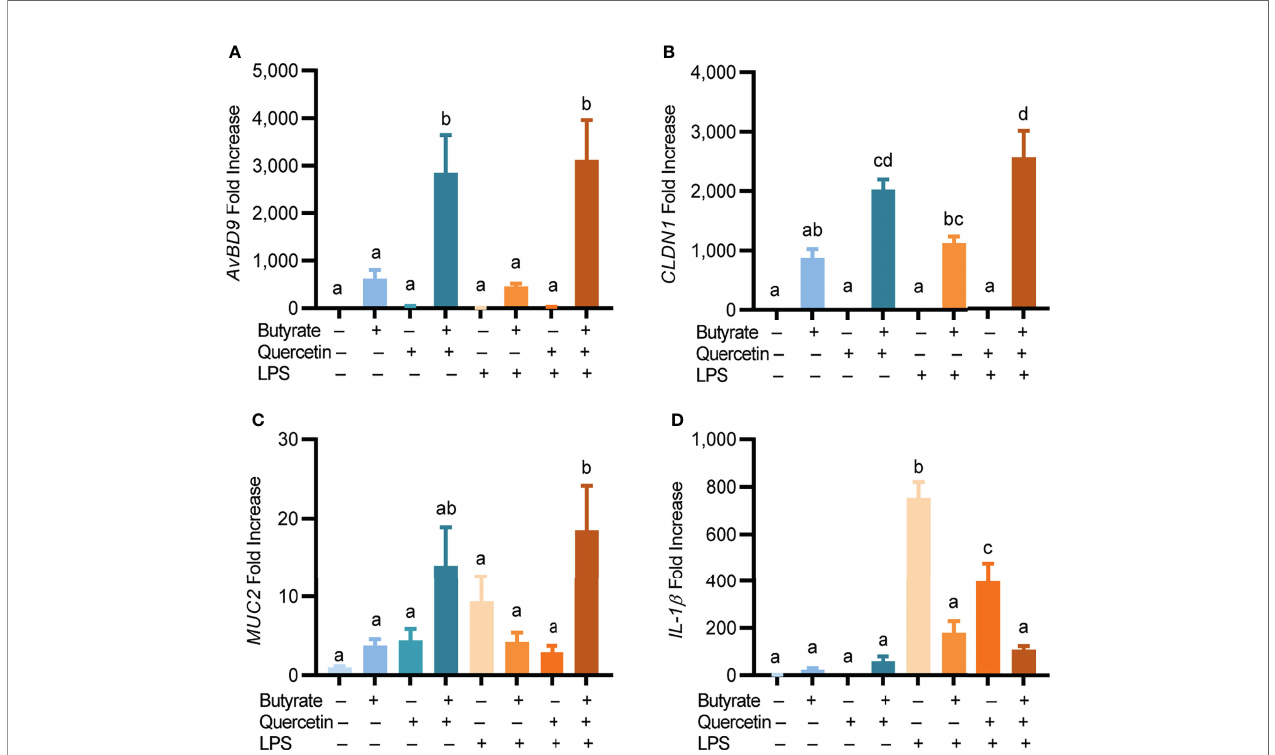
FIGURE 4 | Regulation of HDP, barrier function, and in fl ammatory cytokine gene expressions by quercetin and butyrate. Chicken HTC macrophage cells were treated in duplicate with 20 m M quercetin and 2 mM sodium butyrate separately or in combination for 24 h, followed by stimulation with 10 ng/mL lipopolysaccharides (LPS) for another 3 h. Gene expressions of AvBD9 (A) , claudin 1 ( CLDN1 ) (B) , mucin 2 ( MUC2 ) (C) , and interleukin 1 b ( IL-1 b ) (D) were analyzed by RT-qPCR. Results are presented as means ± SEM of two independent experiments. The bars not sharing common superscript letters are signi fi cantly different ( P < 0.05) as determined by one-way ANOVA and post hoc Tukey ’ s